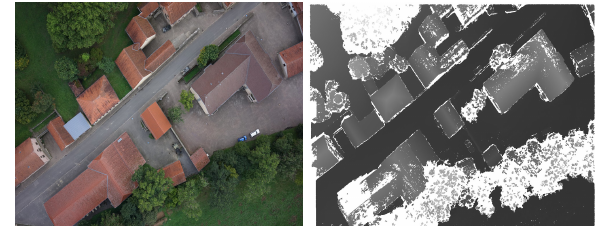
Figure 2. Example image of the urban dataset (Figure 1) and the corresponding disparity map from SGM considering twelve overlapping images showing partly the same scene. The white areas represent areas filtered by consistency checks in